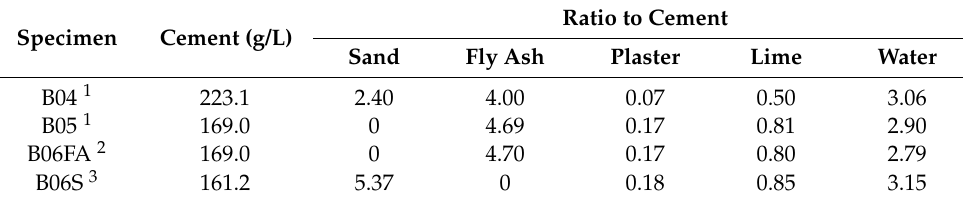
Table 2. Mixing proportion of raw materials of AAC base material. Ratio to Cement Specimen Cement (g/L) Sand Fly Ash Plaster Lime Water B04 1